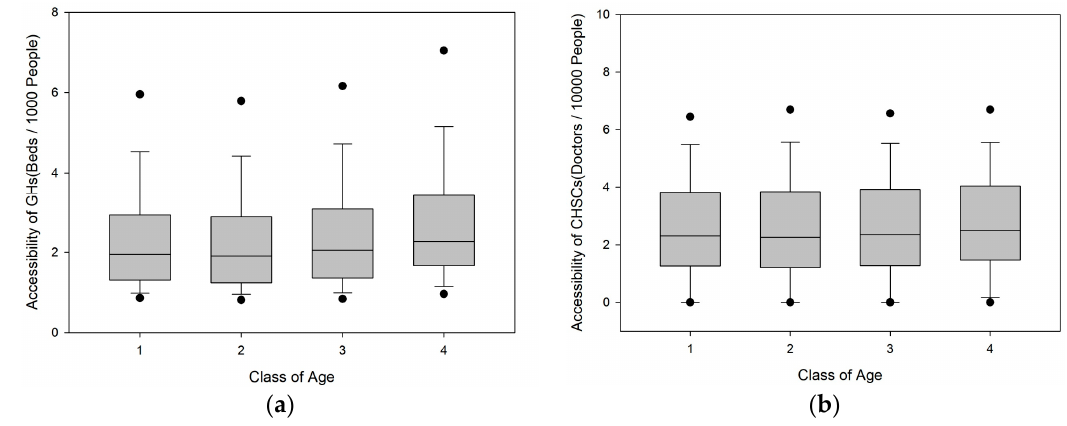
Figure 5. Box-plots of the accessibility for different classes of age. ( a ) Box-plots of the accessibility of GHs; ( b ) Box-plots of the accessibility of CHSCs.